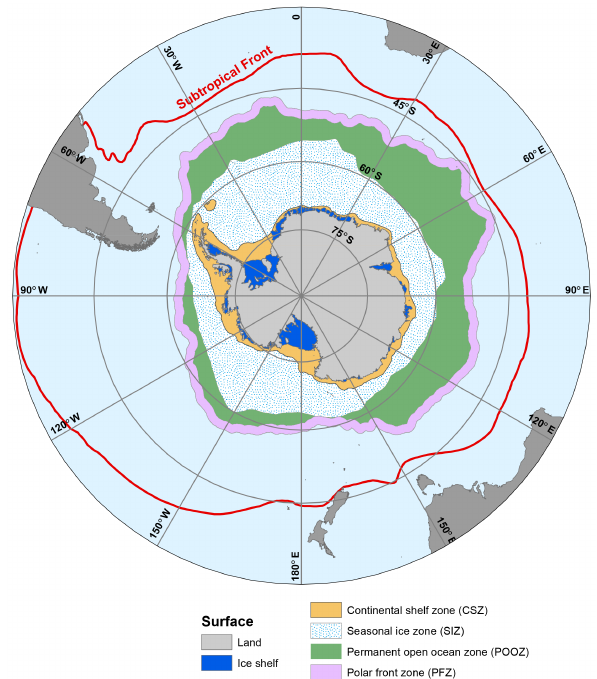
Figure 1. Ecological zones of the Southern